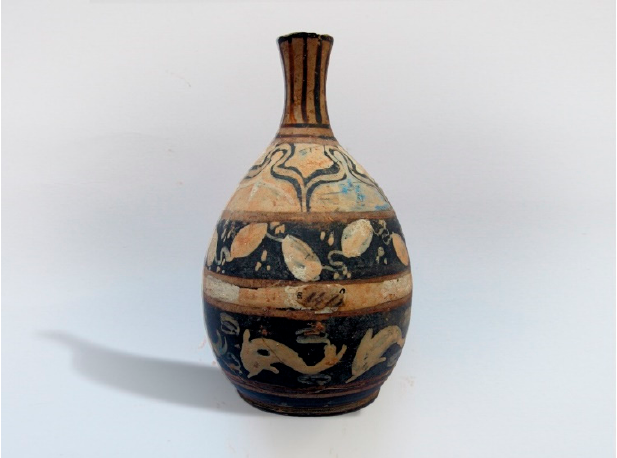
Figure 8. Leaping dolphins (MGW inv. no. 3138); ceramic cosmetic vessel; made in a Liparian workshop; ca. early 3rd century BCE .